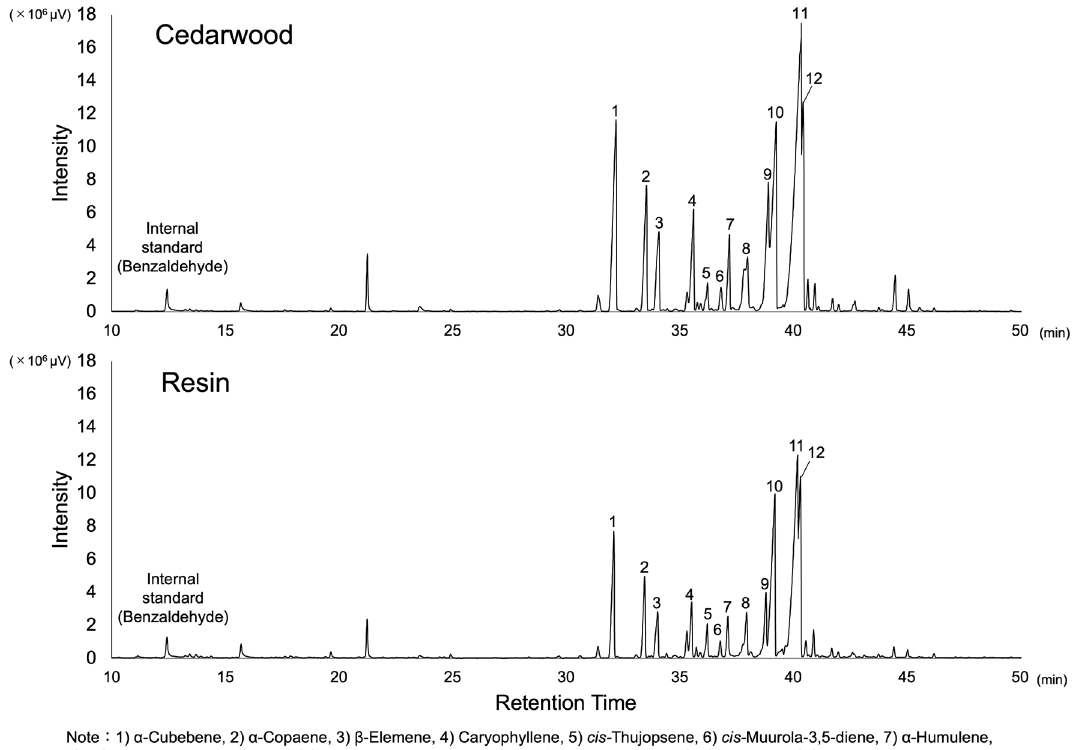
Fig. 3 Representative examples of the volatile organic compounds (VOCs) identified on chromatograms in the GC–MS analysis. Thirteen volatile organic compounds were identified in both the cedarwood and resin huts. The peaks of γ-cadinene and γ-muurolene were superimposed. Each peak area of the 13 identified main sesquiterpene compounds per peak area of the internal standard was approx. twice as large in the cedarwood hut compared to the resin hut